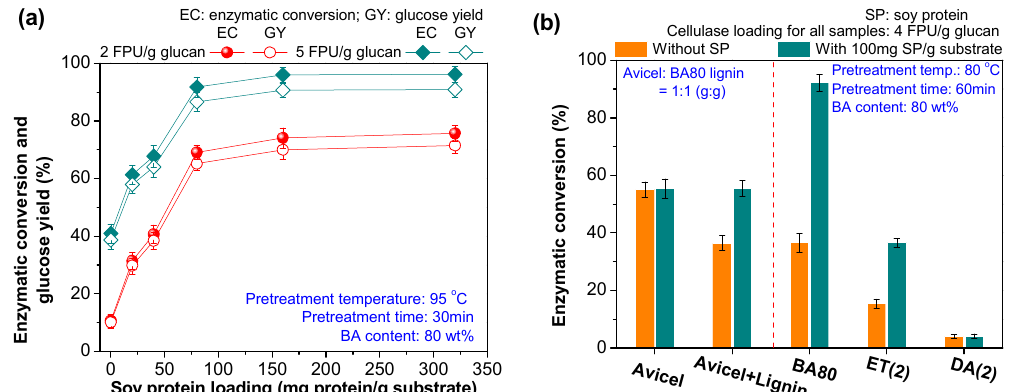
Figure 6. ( a ) Effect of soy protein loading on the enzymatic conversion of cellulose in BA80 pretreated substrate at two enzyme loading (2 and 5 FPU/g glucan); ( b ) comparisons of promotion effects of soy protein on Avicel and substrates from different pretreatments.